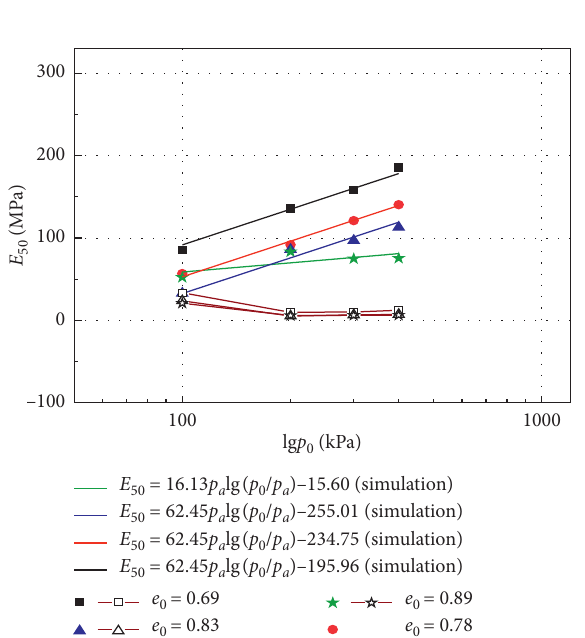
Figure 18: Relationship between E